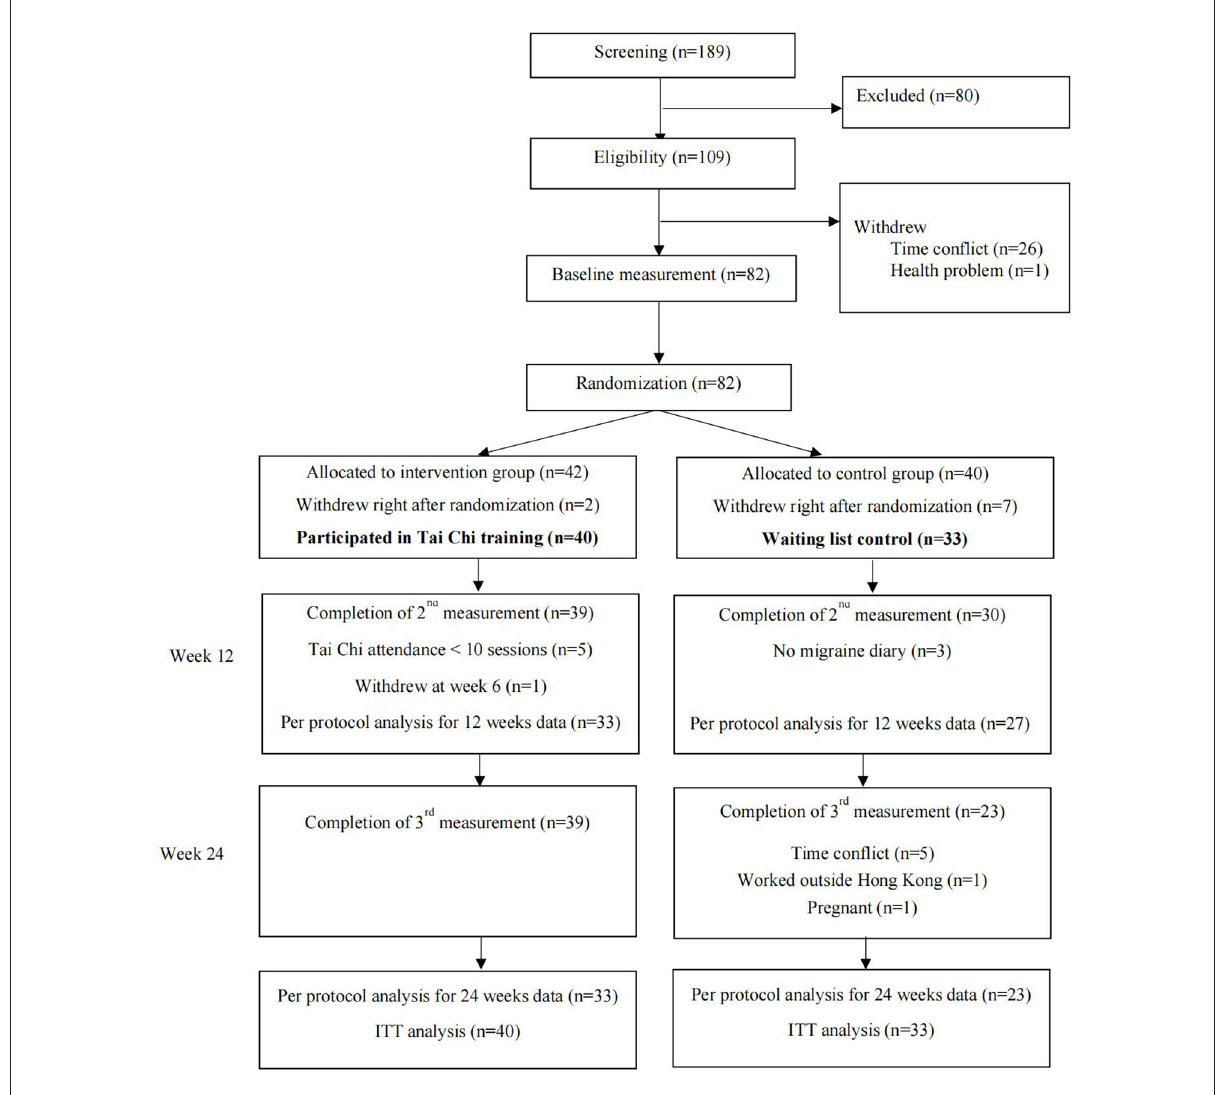
FIGURE1 Flow diagram of the study